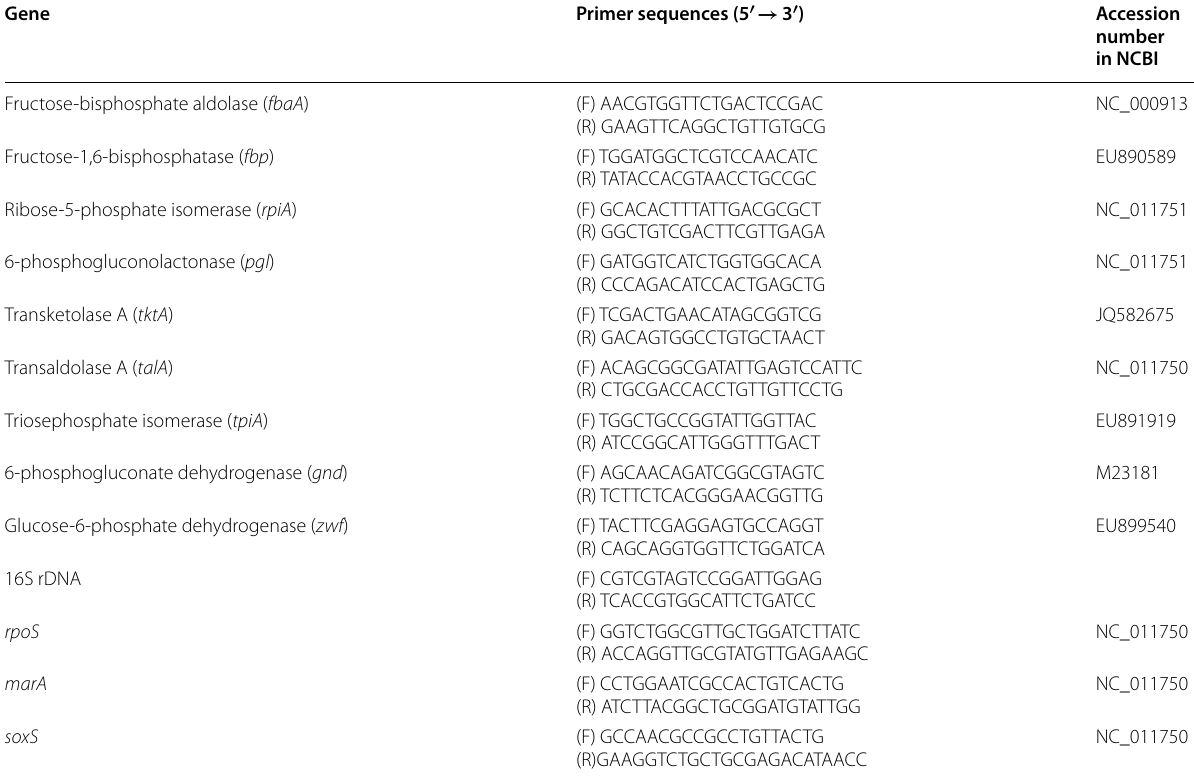
Table 1 Primers used in this study Gene